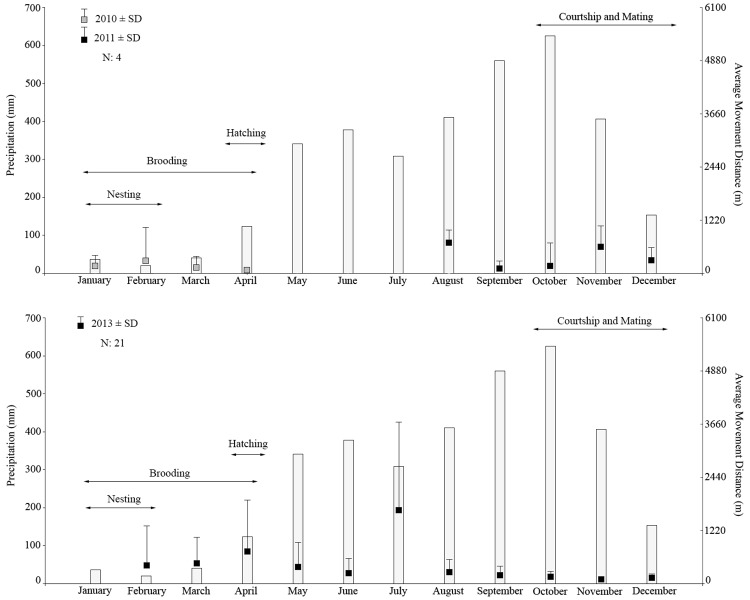
Average movement distances by years and average precipitation.Average movement distances (AMD) of the American crocodile in Coiba Island from 2010 to 2013 related to the average historical precipitation (1971–2014) in the area and the reproductive ecology reported for our previous work [4]. Note the AMD increase in the dry season and decrease in wet season.